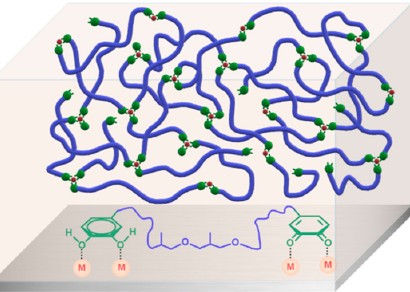
Figure 6. Schematic illustration of the supramolecular network of PEA-dhba-Fe 3+ and interfacial in- teractions between the residual catechol and quinone groups and metal substrate. interactions between the residual catechol and quinone groups and metal